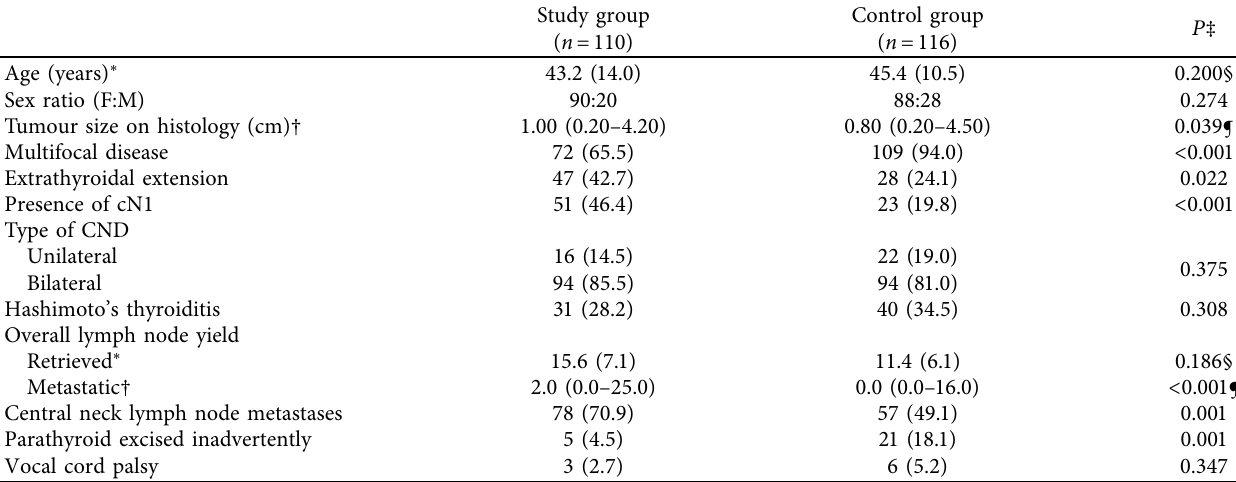
Table 3: Baseline characteristics and surgical results for patients who underwent total thyroidectomy and central neck dissection. Study group